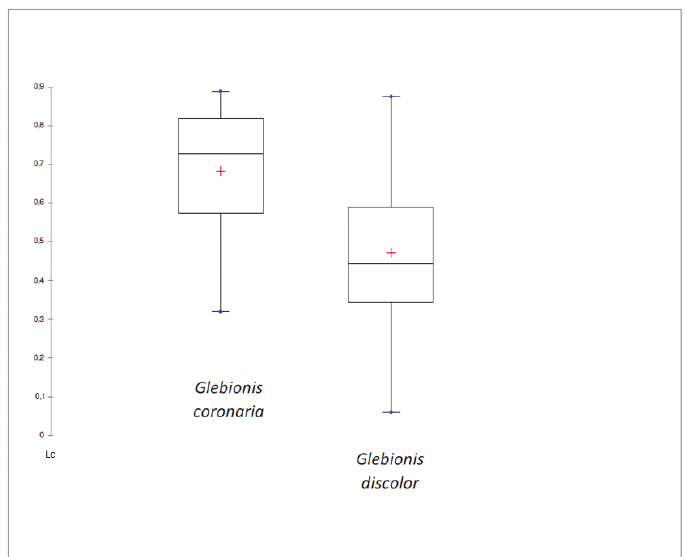
Figure 3. Box plot of alignment of glands distributed along the cypselas of Glebionis coronaria and G. discolor (Lc = Linearity coefficient).